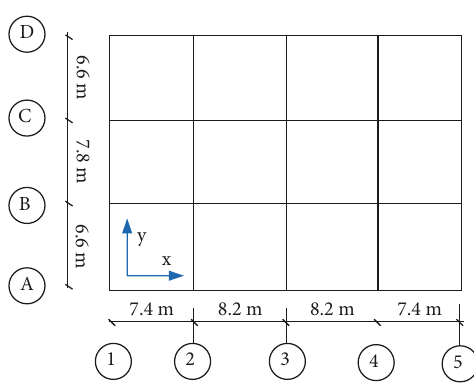
Figure 10: Plane layout of the steel